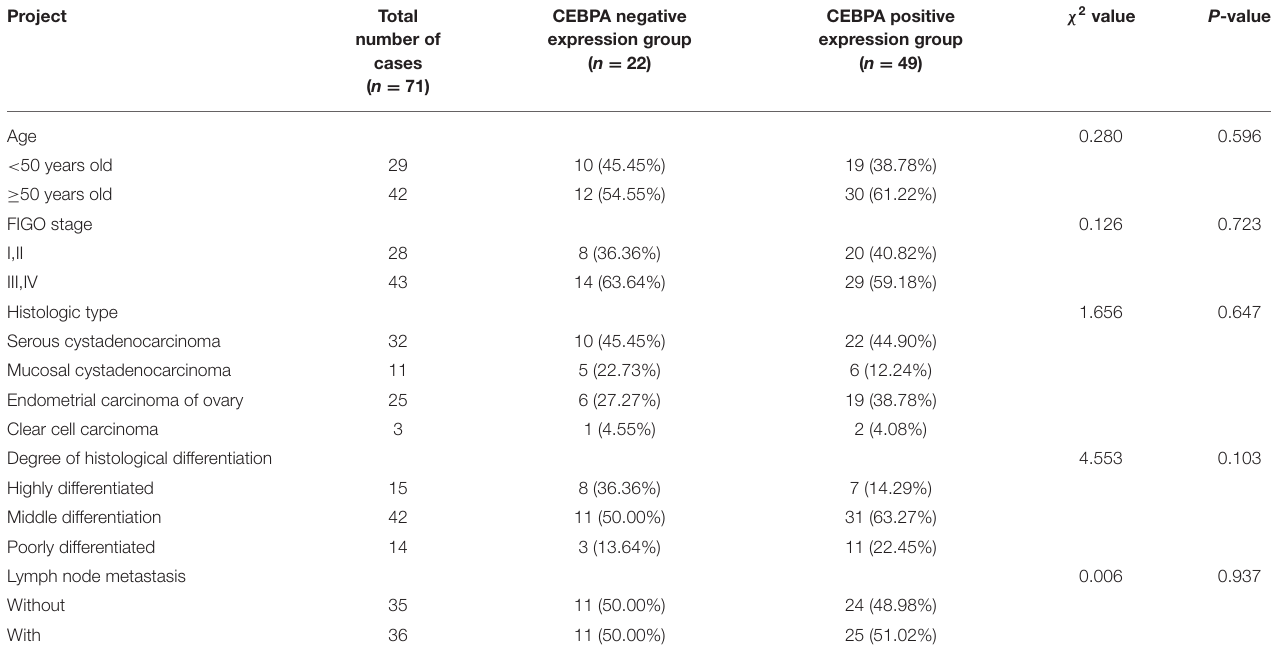
TABLE 3 | Relationship between the expression of CEBPA and the pathobiological characteristics of ovarian cancer patients [ n (%)].